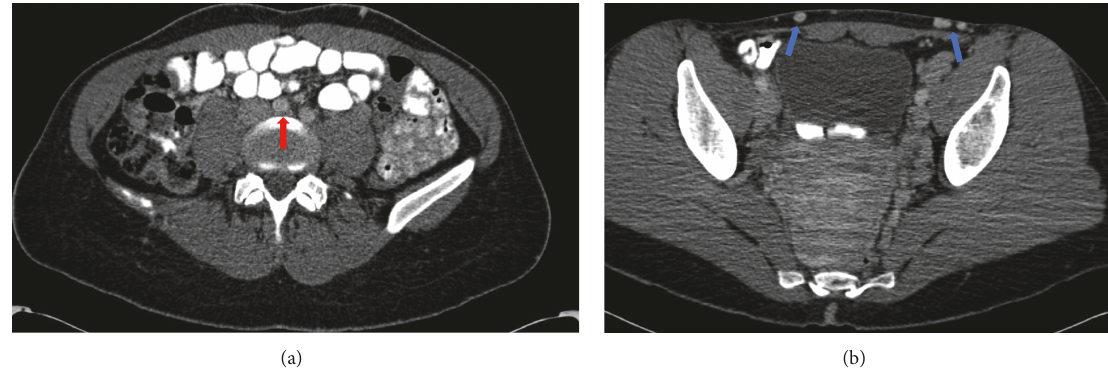
Figure 2: CT venogram of the abdomen pelvis revealed (a) compression of the left common iliac vein by the right common iliac artery (red arrow), and (b) abdominal and left groin varicosities (blue arrows).